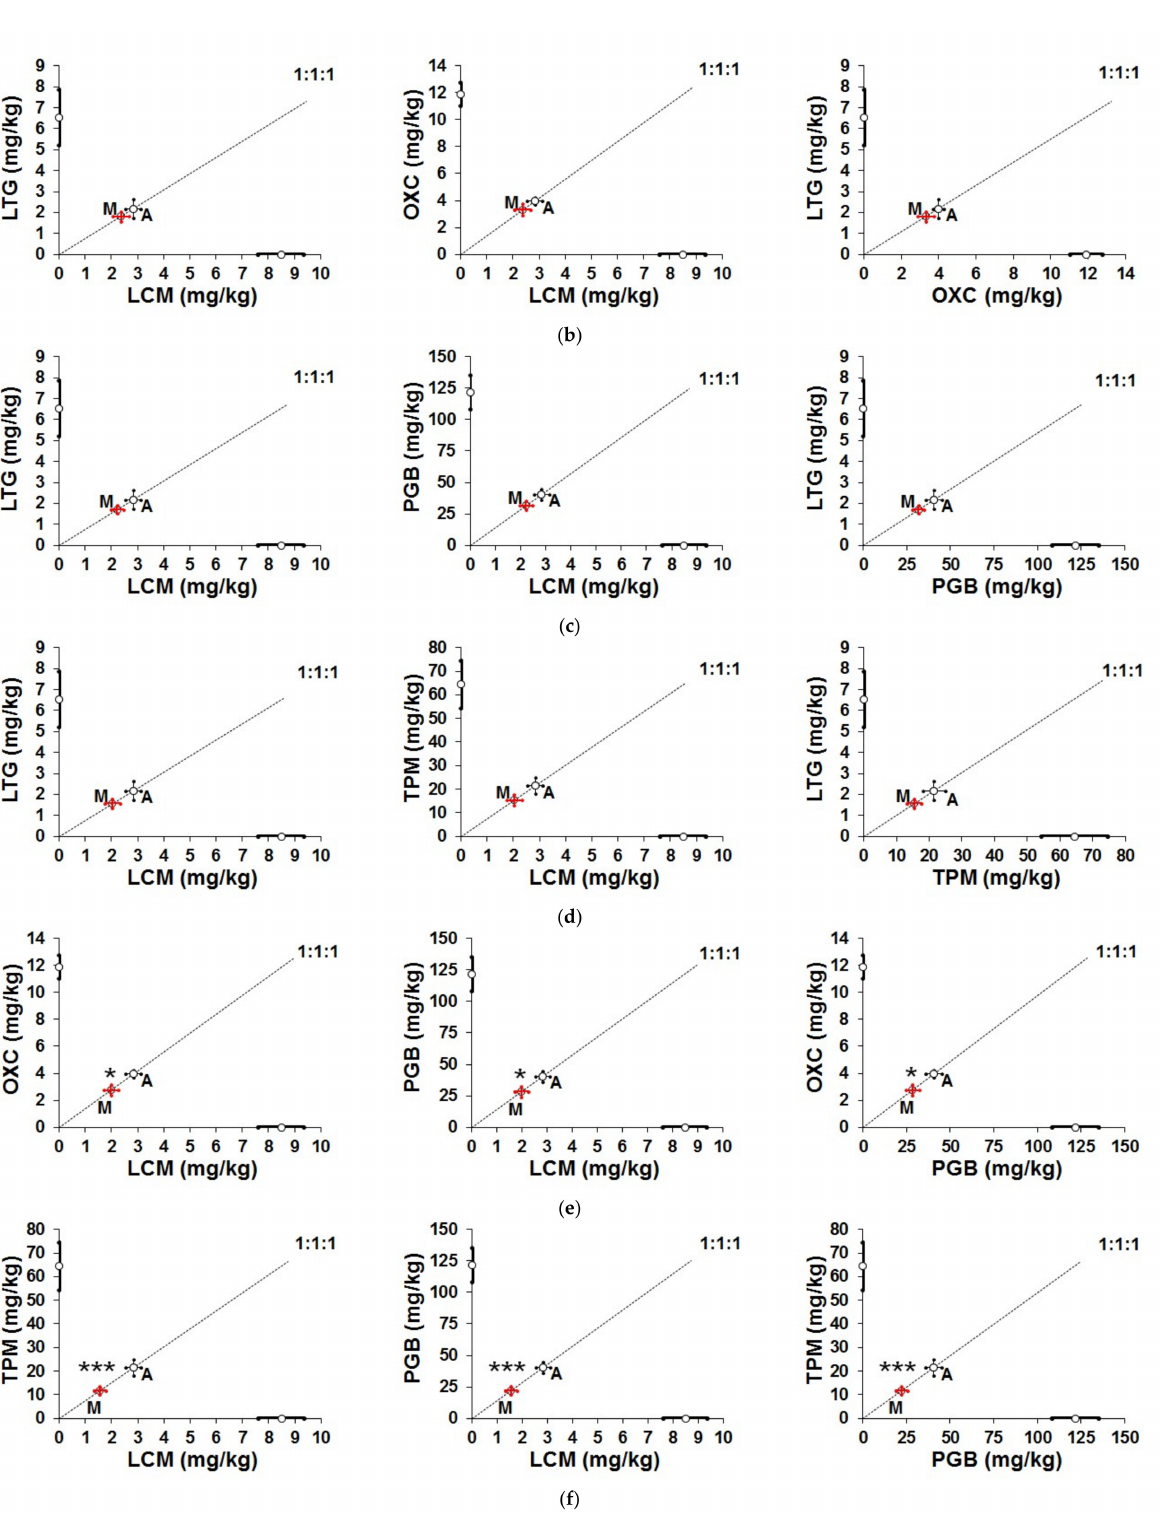
Figure 1. Isobolographic analysis of interactions of various triple ASM combinations: ( a ) additive interaction for the combination of LCM + OXC + TPM; ( b ) additive interaction for the combination of LCM + LTG + OXC; ( c ) additive interaction for the combination of LCM + LTG + PGB; ( d ) additive interaction for the combination of LCM + LTG + TPM; ( e ) synergistic interaction for the combination of LCM + OXC + PGB (* p < 0.05—unpaired Student’s t -test); ( f ) synergistic interaction for the combination of LCM + TPM + PGB (*** p < 0.001—unpaired Student’s t -test). On each graph, point A represents the theoretically calculated additive ED 50 add value ( ± S.E.M. as the error bars), whereas point M displays the experimentally-derived ED 50 exp value ( ± S.E.M. as the error